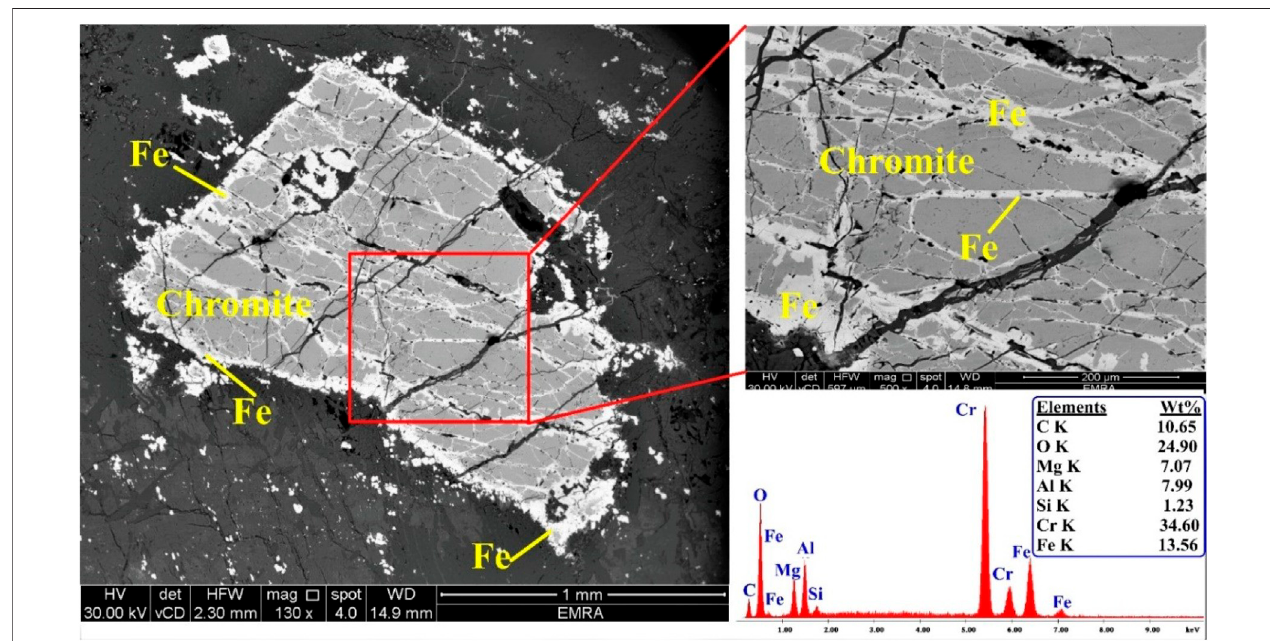
FIGURE 16 | SEM image of the euhedral crystal of Fe-Mg-chromite altered at the rim to iron oxide with sharp contact, serpentinite rocks.